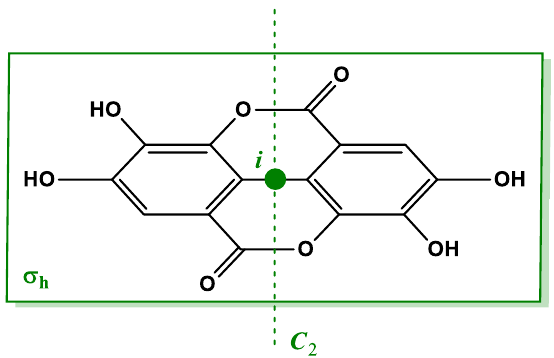
Figure 1. Tilted view of the structural formula of ellagic acid molecule, together with the three symmetry elements: centre of inversion ( i ), rotation axis of order 2 ( C 2 ) and mirror plane (horizontal, σ h ).